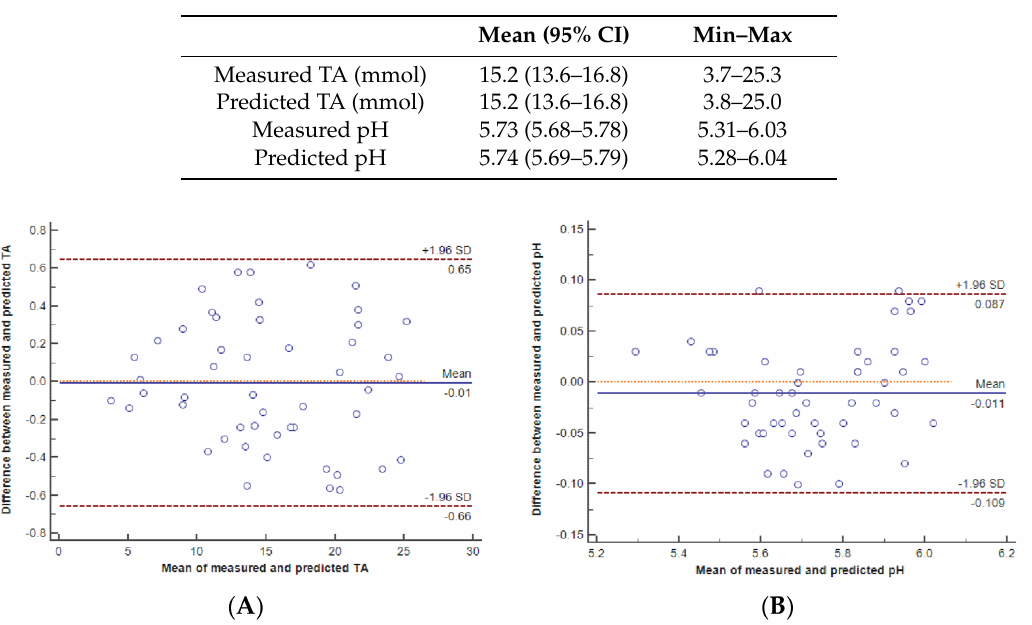
Table 2. Mean, 95% confidence interval (95% CI), and minimum-maximum (min–max) values of the measured and predicted titratable acidity (TA) and pH of compounded parenteral mixtures evaluated in this study ( n = 50).